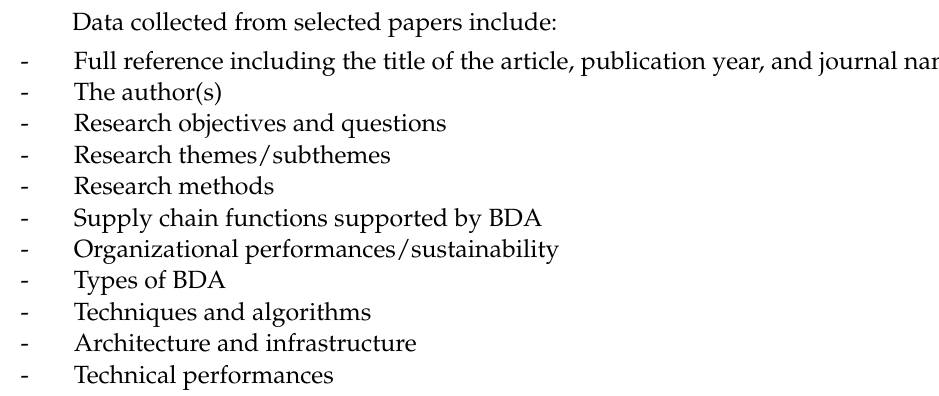
Figure 3. A framework of systematic literature review for BDA in